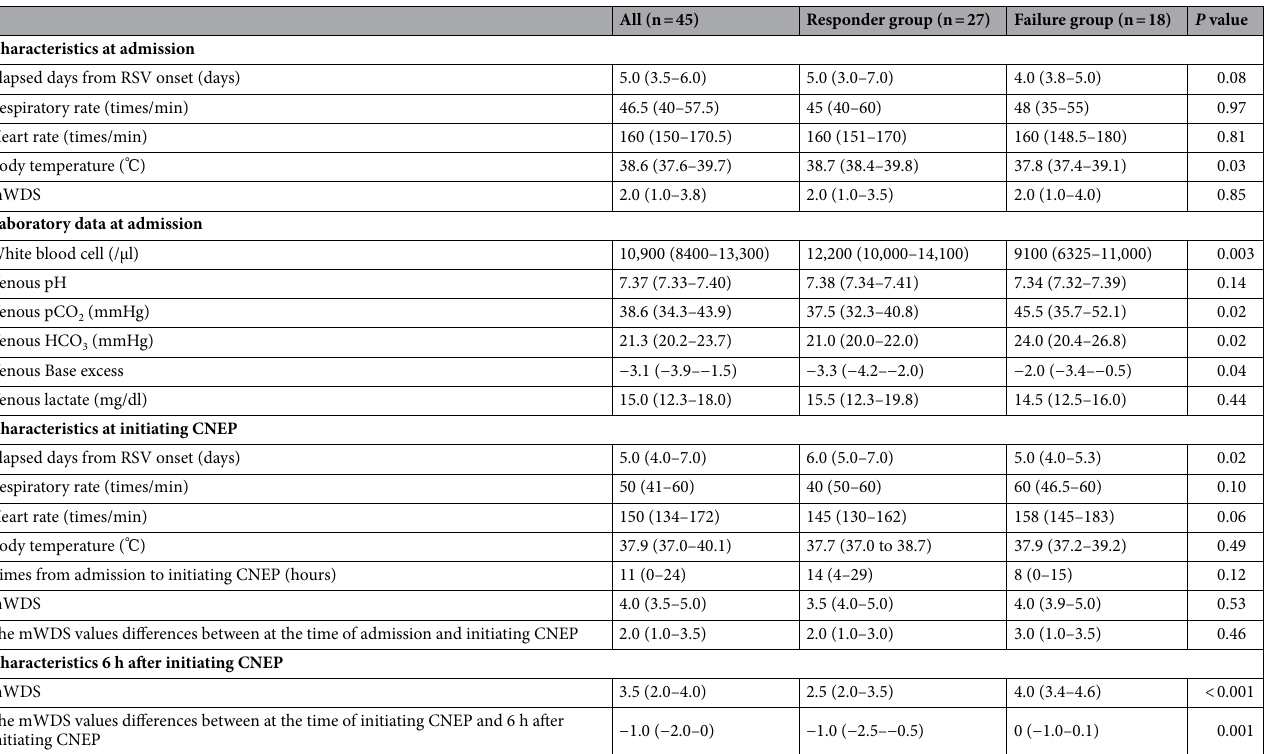
Table 2. Comparison of characteristics between responder and failure group. RSV respiratory syncytial virus, CNEP continuous negative extrathoracic pressure, mWDS modified Wood-Downes Score, Values are median + interquartile